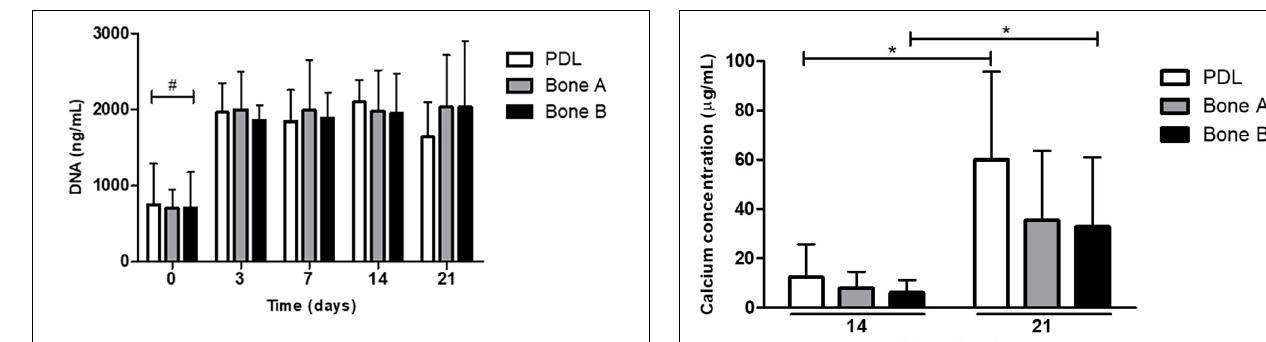
Frontiers in Cell and Developmental Biology |